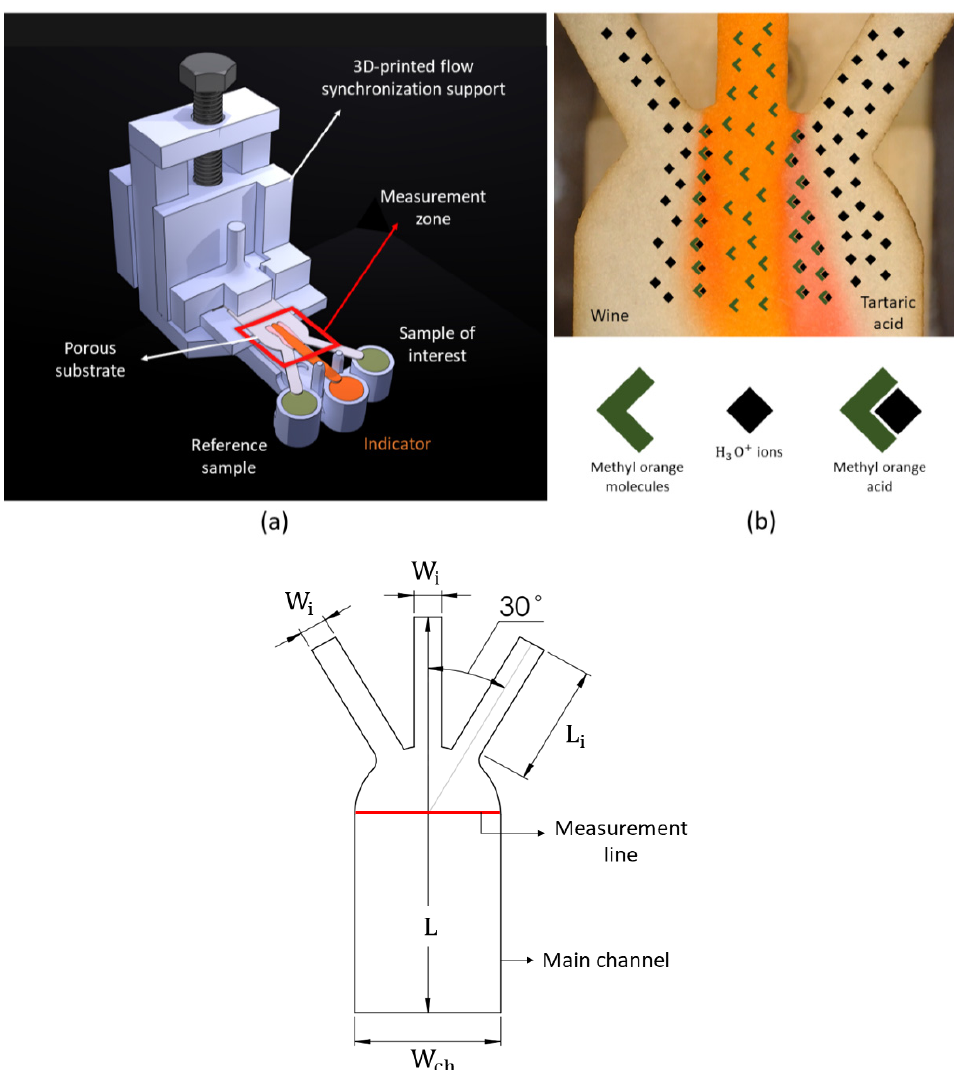
Figure 1. ( a ) Schematic of the µPAD ionic concentration sensor parts. ( b ) Physics of the ionic concentration measurement. ( c ) Porous substrate geometry.